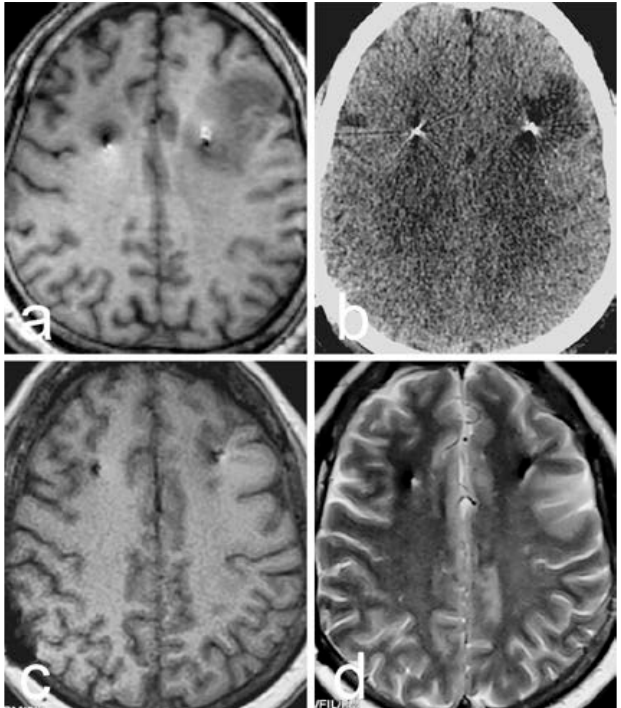
Figure 4. DBS of the globus pallidus internus. ( a ): The intraoperative 3D T1-weighted image shows low signal around the left electrode. ( b ): A CT scan conducted on 1 day postoperation shows the low density of the ischemic infarct. ( c , d ): T1- and T2-weighted MRI images at 9 months postoperation show a slight abnormality around the leads.